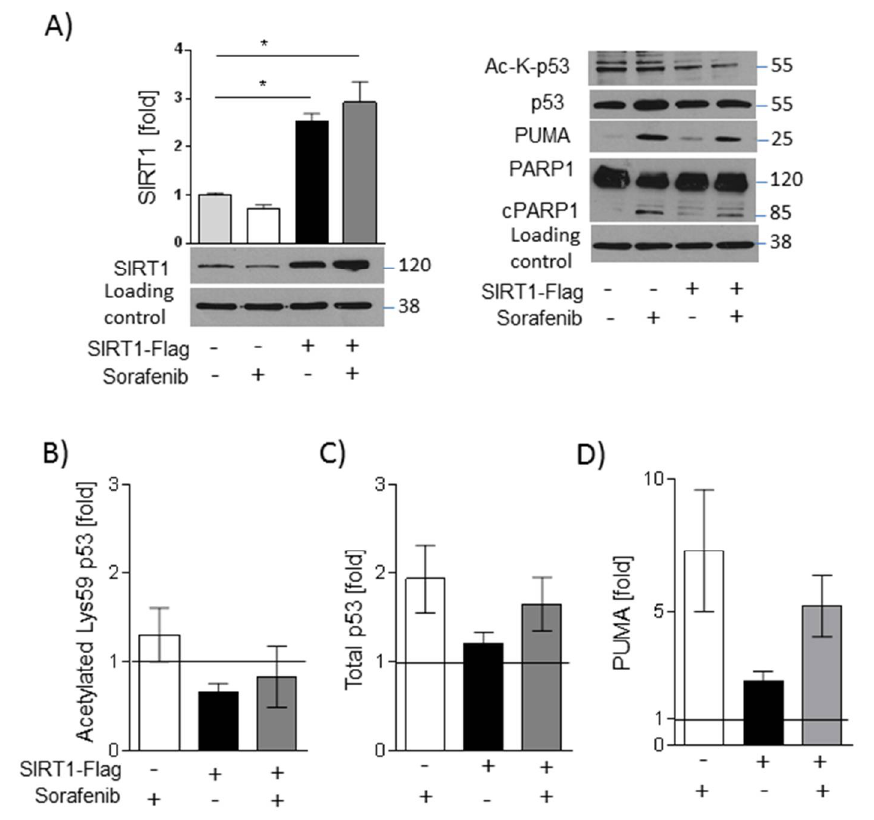
Figure 6. SIRT1 overexpression leads to downregulation of sorafenib-induced p53 signaling . HUH7 cells were stimulated with sorafenib (5 µ M). SIRT1 was overexpressed in HUH7 cells by electroporation. ( A ) Left: Densitometric analysis of SIRT1 was done using ImageJ (NIH) [17]. SIRT1 was normalized to mean values of GAPDH, which served as a loading control. Right: Acetylated Lys382-p53, total p53, poly (adenosine diphosphate ribose) polymerase 1 (PARP-1), and p53 upregulated modulator of apoptosis (PUMA) was detected by Western blot analysis, GAPDH served as a loading control. One representative blot out of three experiments is shown. Densitometric analysis of ( B ) acetylated Lys382-p53, ( C ) total p53, and ( D ) PUMA was done using ImageJ (NIH). Solvent control (DMSO) was set = 1, indicated by a line. One representative blot out of three experiments is shown. Data are shown as mean ± SEM. Sirt1-FLAG: overexpression plasmid for Flag-tagged SIRT1.